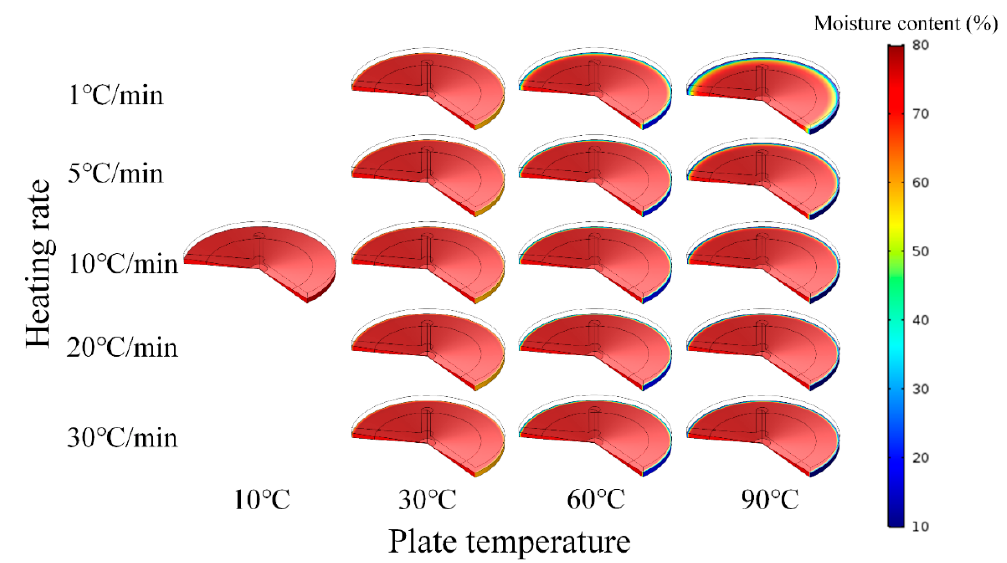
Figure 6. Moisture distribution of Alaska pollock surimi during temperature sweep at different heating rates.